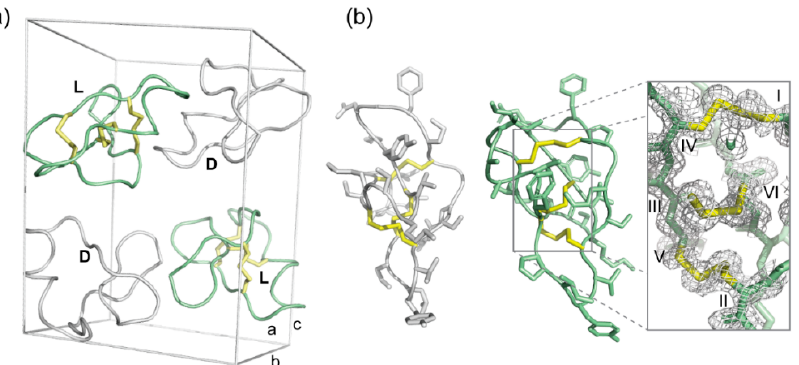
Figure 4. Quasi-racemic crystallography of hyen D (7RIH). ( a ) Unit cell of a quasi-racemate of wild- type hyen D in space group P1 2 1 1. Hyen D is shown in green and D -[I11L]hD in white. ( b ) Ribbon representation of hyen D (green) and D -[I11L]hD (white). Inset: 2Fo-Fc electron density map of the cystine knot shown at a σ level of 1.0.